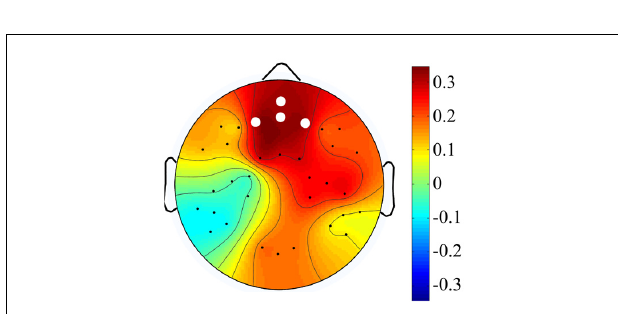
FIGURE 5 | Scalp distribution of theta –WMC association Coefficients for the correlation between change in theta power andWMC. White dots indicate cluster with p ≤